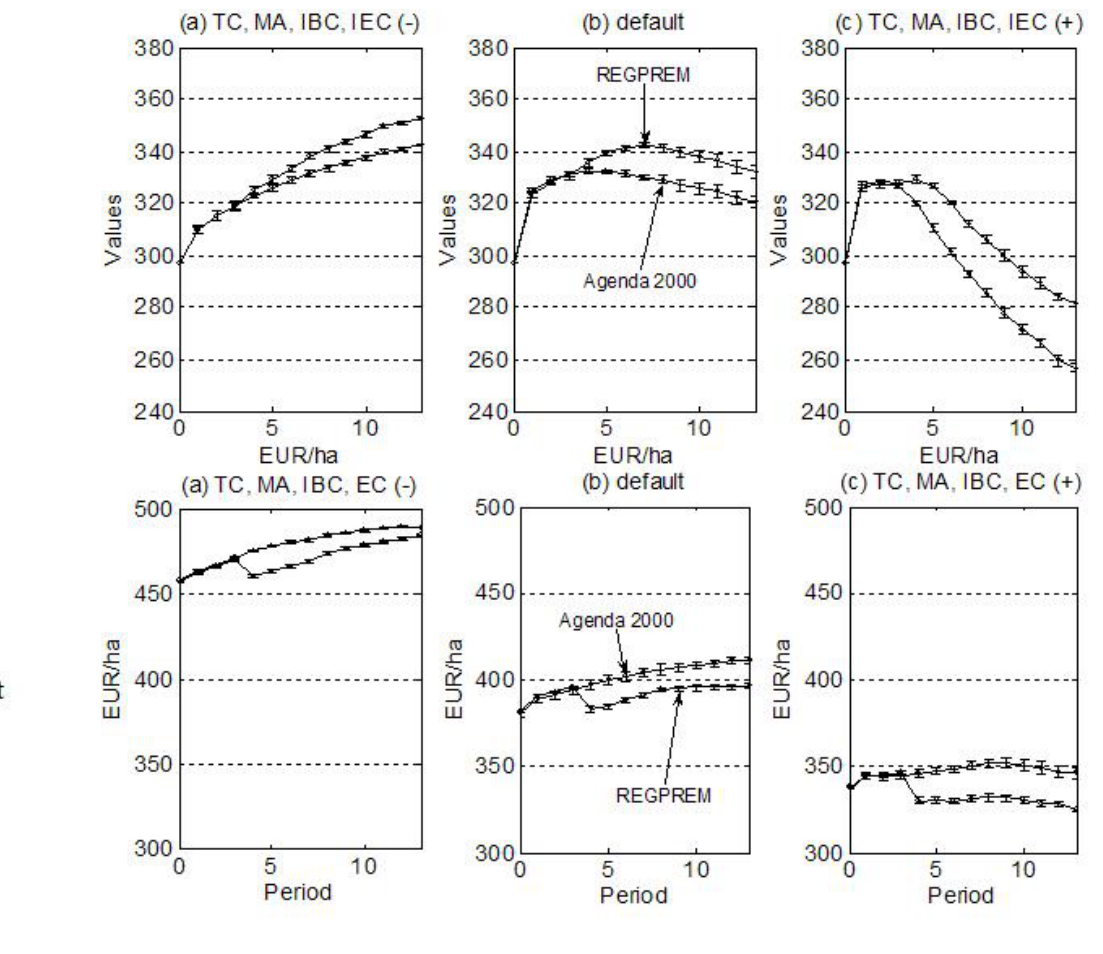
Fig. 8. Evolution of average rent and profit over 14 simulation periods and two policies, i.e., Agenda 2000 and the decoupled policy (REGPREM) for low factor levels (-), default, and high factor levels (+). Averages of five replications and standard errors. IBC stands for interest on borrowed capital, IEC stands for interest on equity capital, MA stands for cost savings due to managerial ability, and TC stands for technological